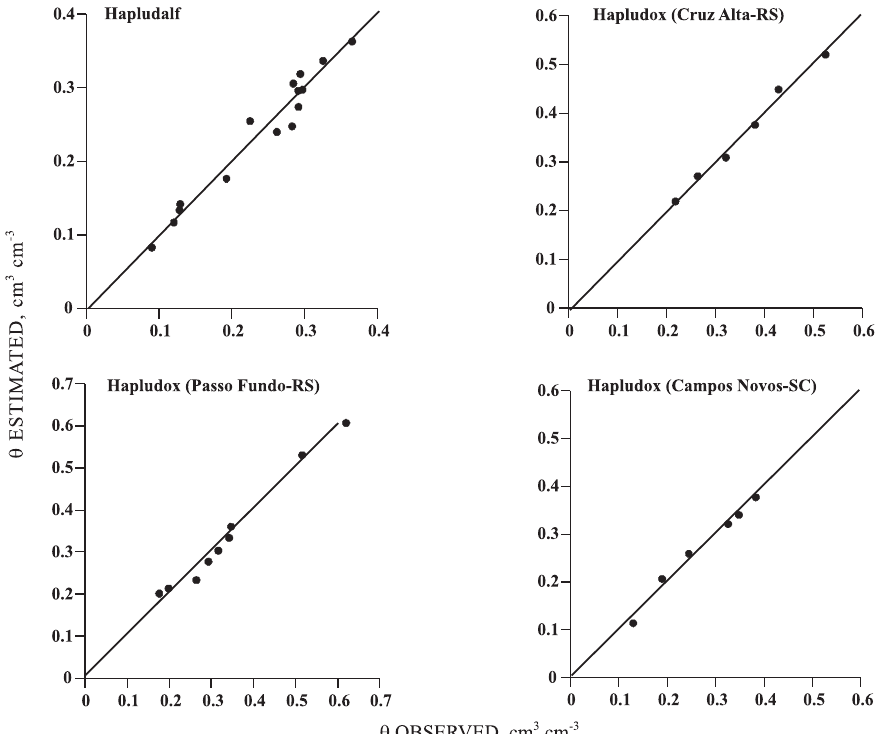
model.Figure 7. Relationship (1:1 graphic) between the volumetric soil moisture observed and that estimated with the linear